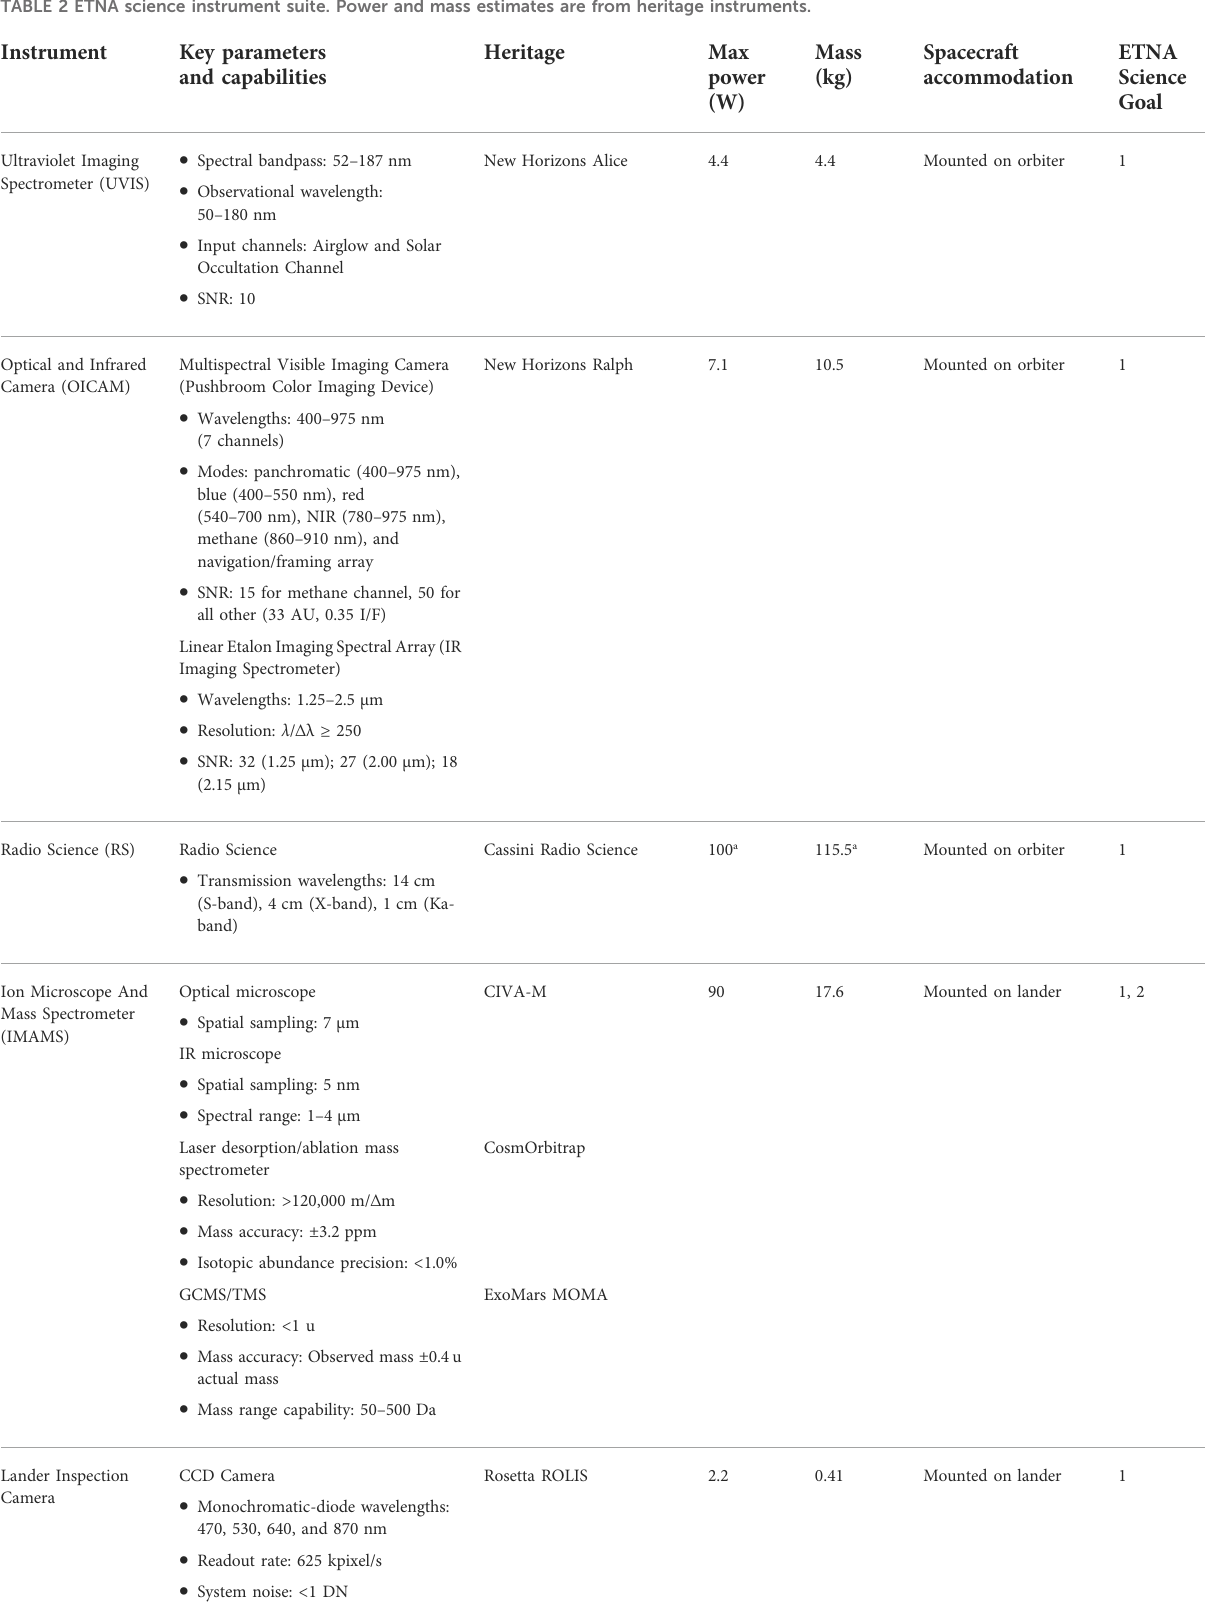
TABLE 2 ETNA science instrument suite. Power and mass estimates are from heritage instruments.